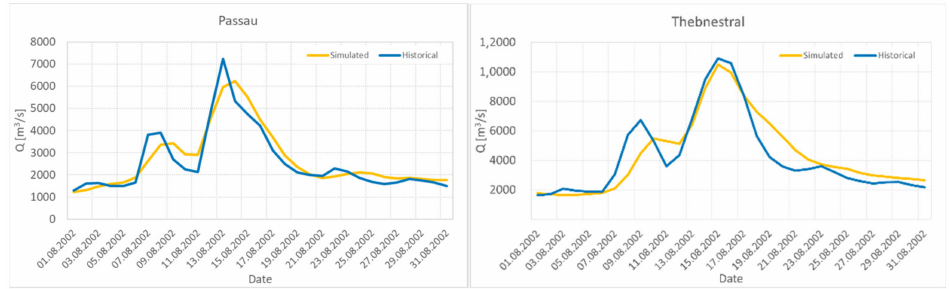
Figure 2. Example of the R-R model calibration–observation vs. model